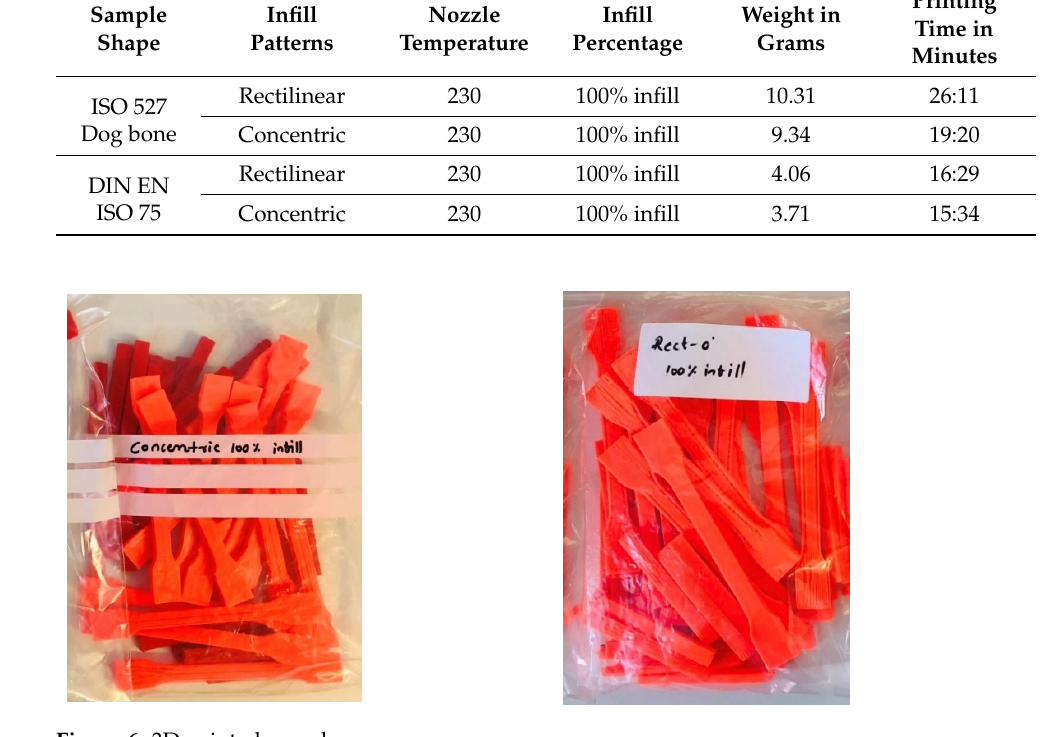
a B Figure 7. 3D printing of DIN EN ISO 75 samples. (A- while printing, B- Printed Samples) 3.2. Injection Molded Samples Preparation Injection molding process illustrated in Figure 8 is one of the most common process for manufacturing plastic parts in large volumes. In the injection molding process, the chopped filament PLA pellets [18] were used as the raw material. In this process, when the raw material was taken, the automatic Hooper and the required melting point tem- perature for the plastic material were given as the input to the machine. The proper mold temperature, mold cavity pressure, holding pressure, flow speed, and volume were properly uploaded, and then the PLA dog bone samples were manufactured [19]. In this research work, injection-molded specimens were manufactured using a 15t injection molding machine (Arburg, Lossburg, Germany) with cavity pressure and melt temperature measurements [20]. PLA is the material used. PLA filament is granulated, dried, and manufactured as a raw material for injection molding. Around 80 samples of PLA material were manufactured to draw the comparison with 3D-printed samples under different environment conditions.